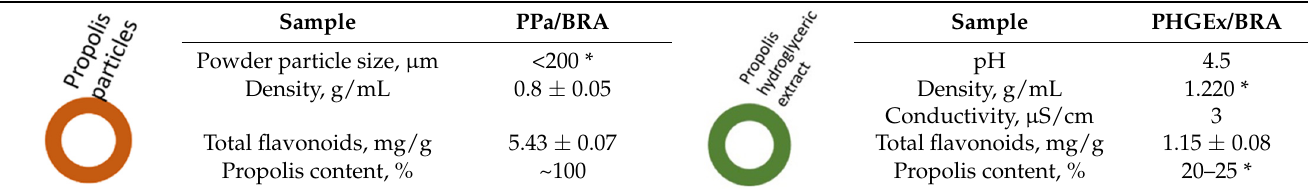
Table 2. Properties of propolis powder and hydroglyceric propolis extracts.